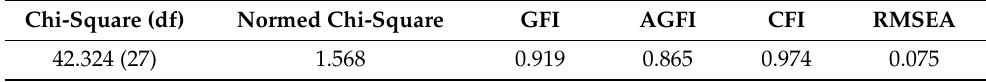
Table 2. Organisational Culture Model Fit.